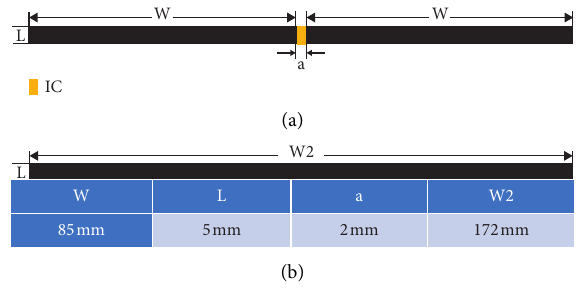
Figure 2: Design of the bending tag antenna (a) and the 3D-printed substrate